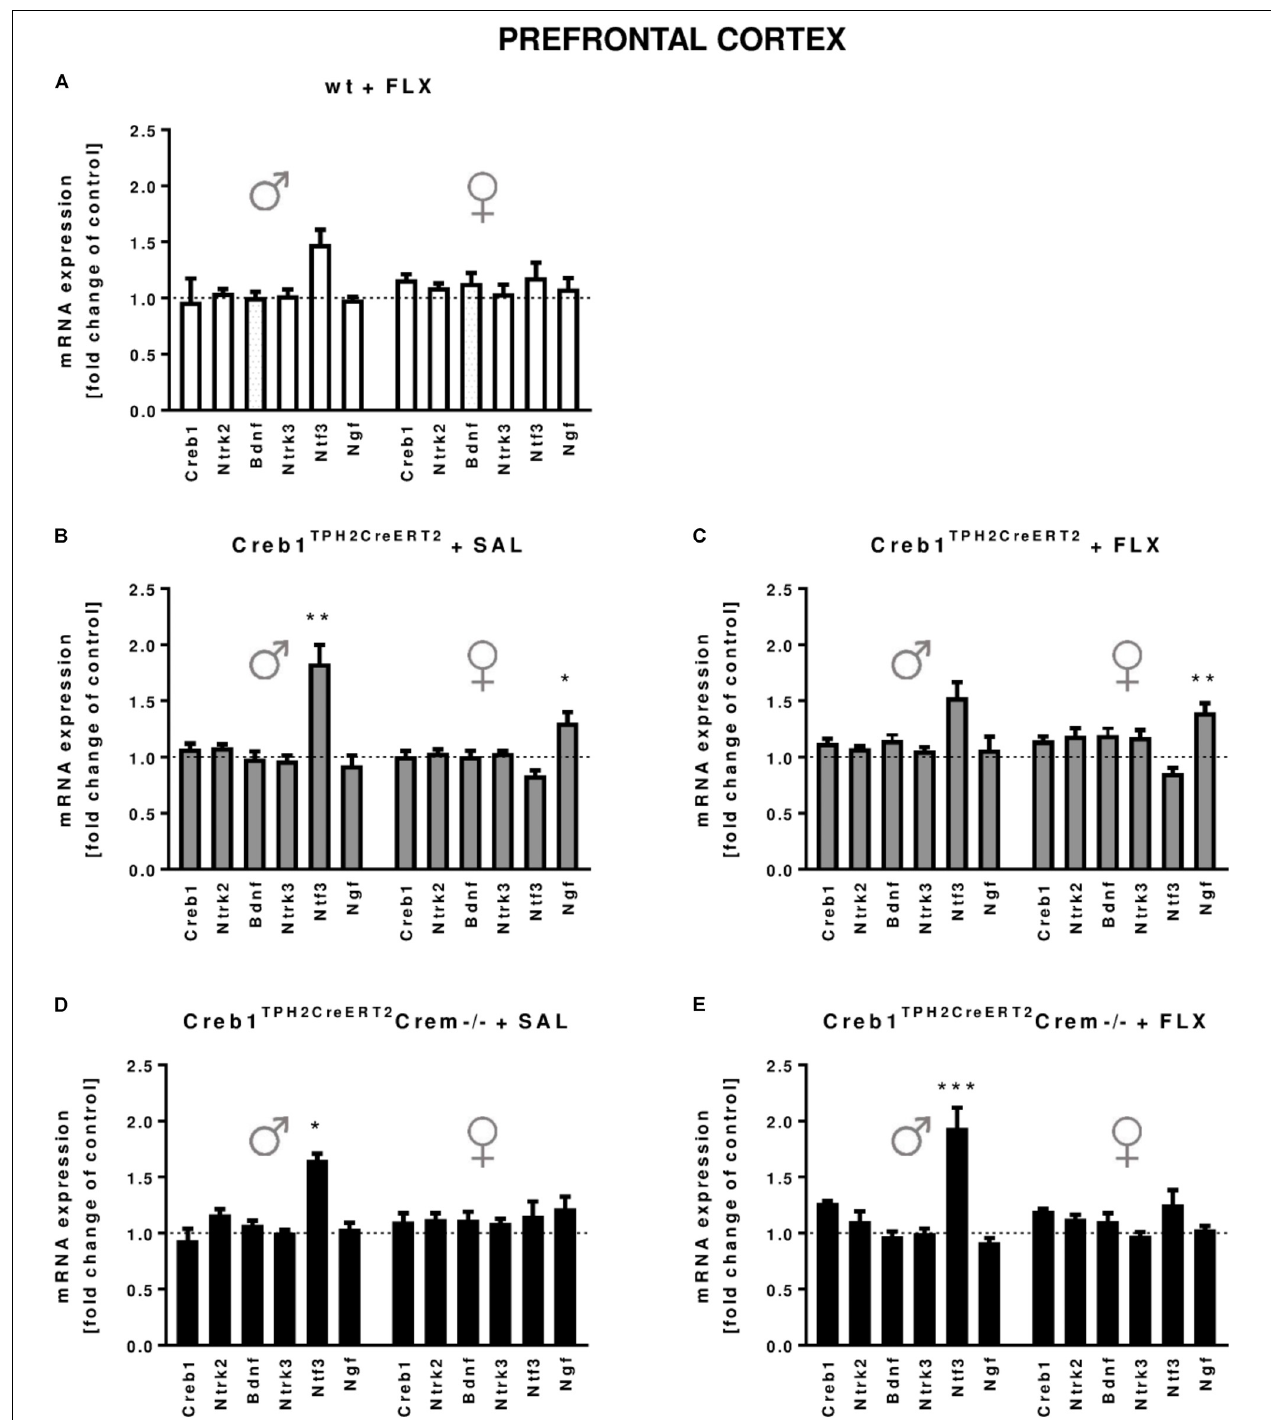
FIGURE 3 | mRNA expression of genes encoding for Creb1, neurotrophins (Bdnf, Ngf, and Ntf3) and their receptors (Ntrk2, Ntrk3) in the prefrontal cortexes (PFCs) of saline- and fluoxetine-treated wild-type, Creb1 TPH2CreERT2 , and Creb1 TPH2CreERT2 Crem–/– mice. In the PFC of male Creb1 TPH2CreERT2 (saline-treated mice) and Creb1 TPH2CreERT2 Crem–/– mutants (saline- and fluoxetine-treated mice), increased NTF3 mRNA levels were observed. However, Creb1 TPH2CreERT2 females after both saline and fluoxetine treatment show increased Ngf mRNA expression levels. Bars represent fold changes in the mRNA expression of Creb1, Bdnf, Ngf, Ntf3, Ntrk2, and Ntrk3 vs. that in wild-type non-treated animals (dot line) in the PFC of (A) wild-type fluoxetine-treated, (B,C) Creb1 TPH2CreERT2 saline- and fluoxetine-treated, and (D,E) Creb1 TPH2CreERT Crem–/– saline- and fluoxetine-treated mice. All graphs represent data from males (left) and females (right). Data are presented as the mean ± SEM. ∗ p < 0.05, ∗∗ p < 0.01, ∗∗∗ p < 0.001 vs. saline-treated wild-type mice of the same sex. W/t, wild-type; FLX, fluoxetine.